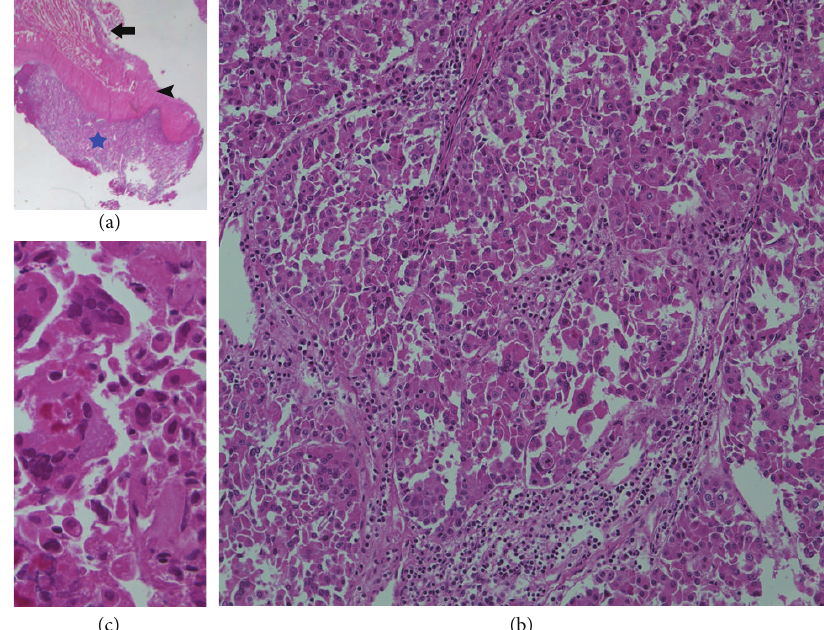
Figure 4: (a) A nodular proliferating mass (blue star) under the skeletal muscle (thick arrow) and fascia (arrow head) (H&E, × 10). (b) The tumor reveals trabecular or acinar arrangement surrounded by sinusoidal vessels (H&E, × 200). The individual tumor cells are hepatoid (thick eosinophilic and granular cytoplasm, round central nuclei, prominent nucleoli). (c) Some tumor cells are pleomorphic with frequent multinucleation (Edmondson-Steiner Nuclear grade 4/4) (H&E, ×